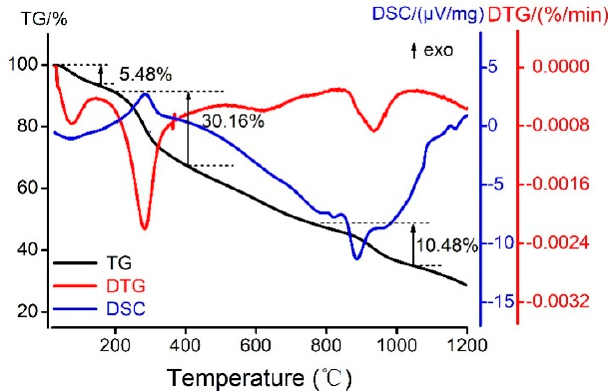
Figure 5. The thermogravimetric and differential scanning calorimeter (TG/DSC) curves of melting process of Kae-Ga complex in N 2 .